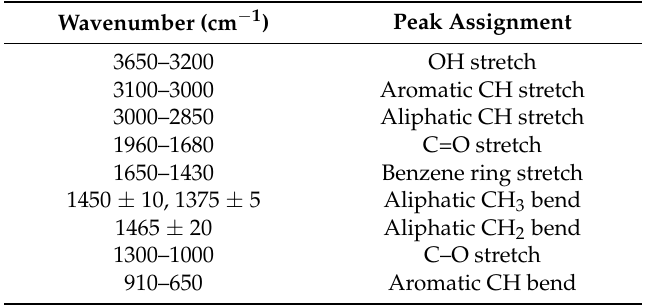
Table 2. Peak identification of the FTIR spectra of BPF